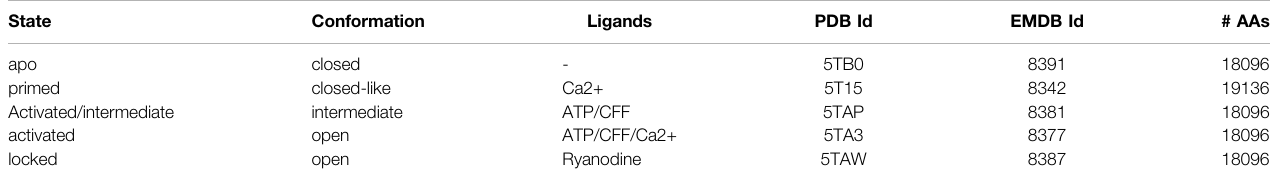
TABLE 2 | RyR1 putative functional states, conformations, ligands, PDB and EMDB identi fi ers used for this work. # AAs stands for number of amino acids in the corresponding sequence. CFF stands for caffeine. All data are for rabbit